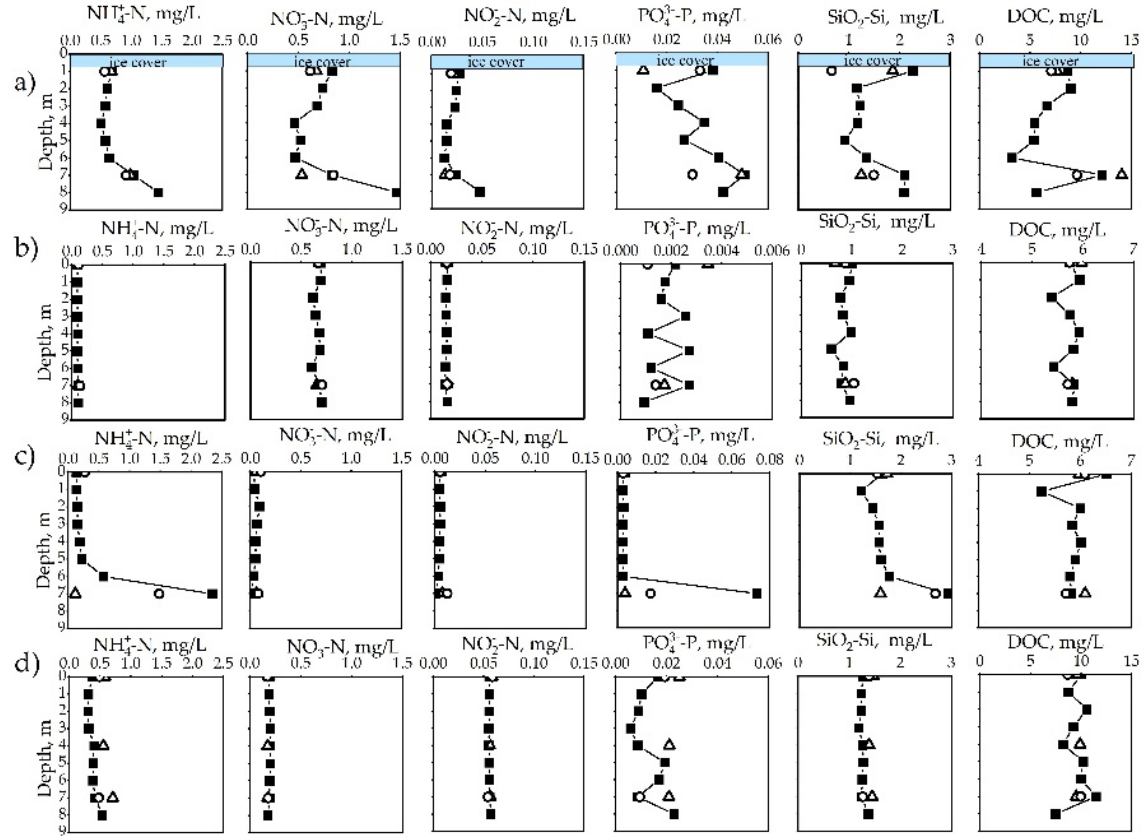
Figure 5. Spatial variation and vertical profiles of nutrient and DOC concentrations in Lake Bulan.